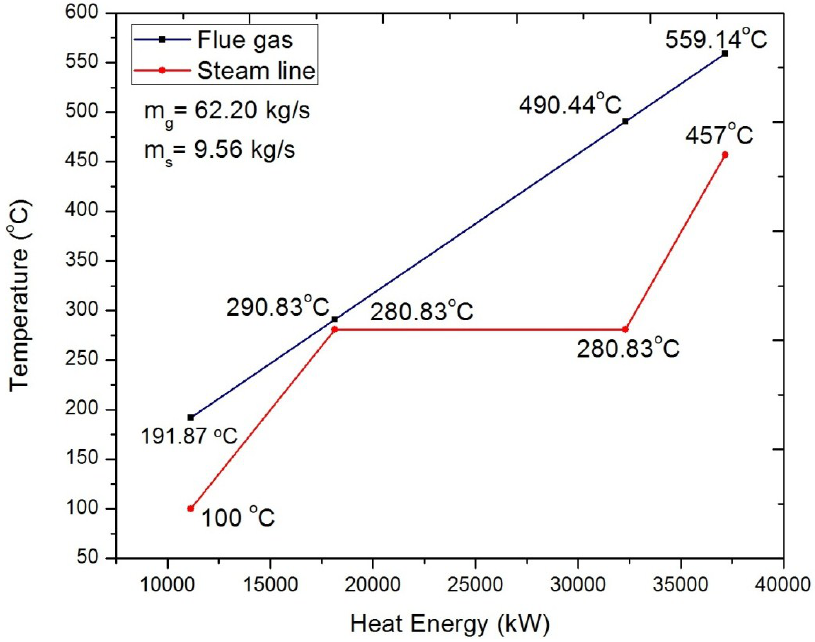
Figure 7. Q-T profile of HRSG in July.